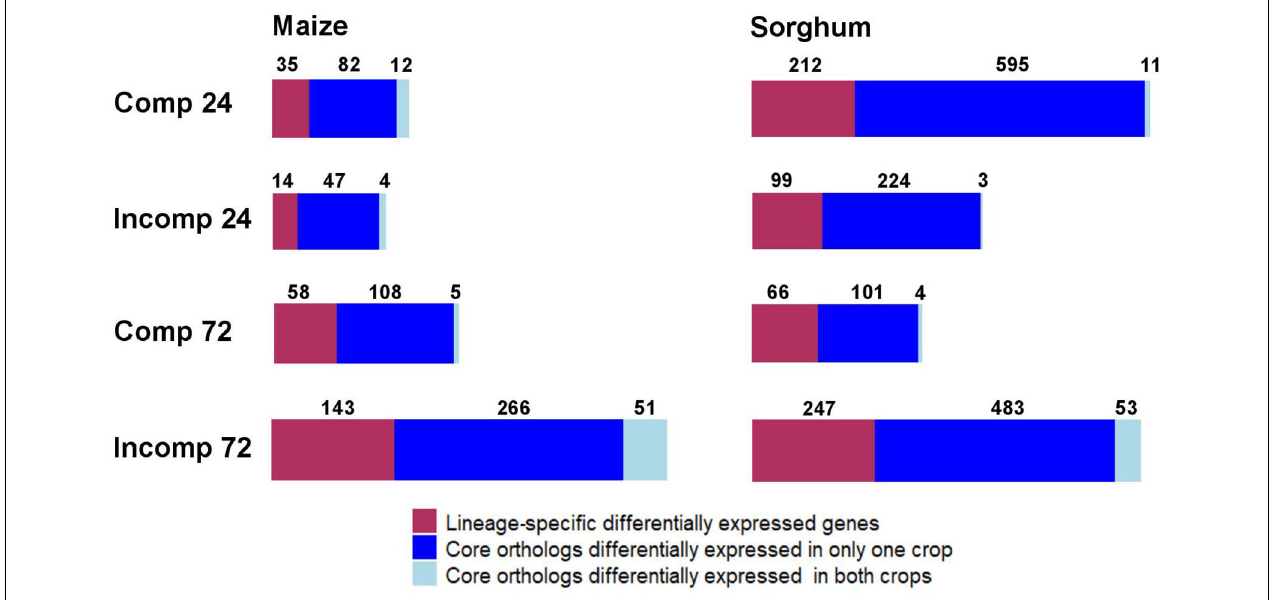
FIGURE 2 | Summary of the number of lineage-specific differentially expressed (DE) genes, core orthologs that were DE in one crop, and core orthologs that were DE in both crops (a.k.a. shared differentially expressed orthologs) in maize and sorghum, in response to Exserohilum turcicum . “Comp 24” indicates compatible interaction at 24 h after inoculation (hai), “Incomp 24” indicates incompatible interaction at 24 hai, “Comp 72” indicates compatible interaction at 72 hai and “Incomp 72” indicates incompatible interaction at 72